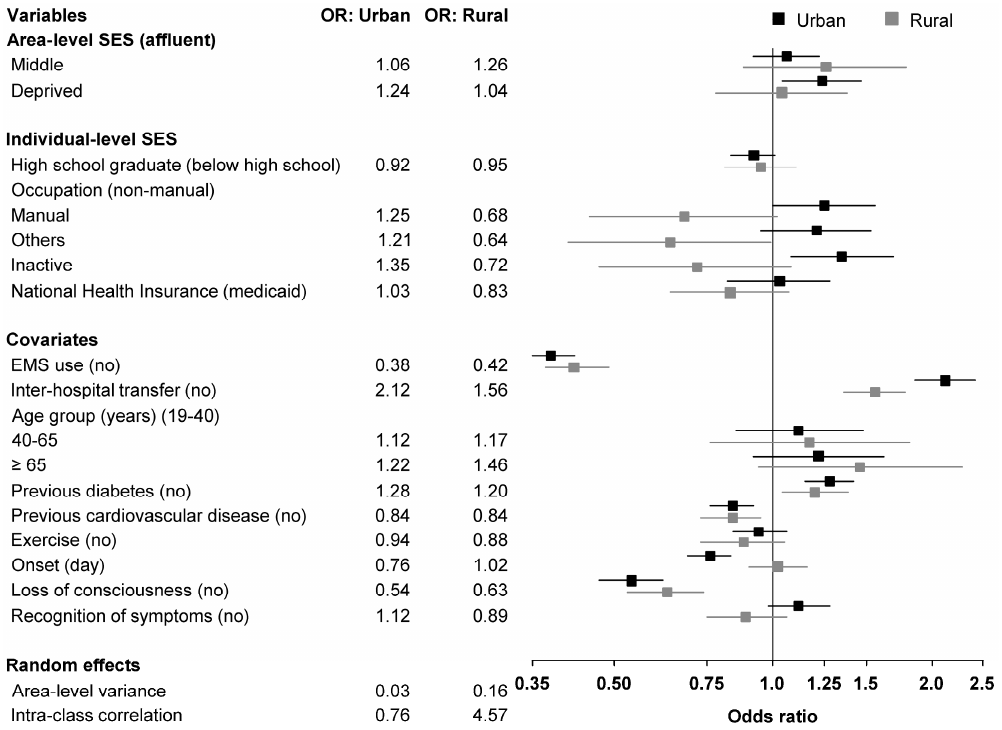
Figure 2. Odds ratio of prehospital delay stratified by urbanization status.